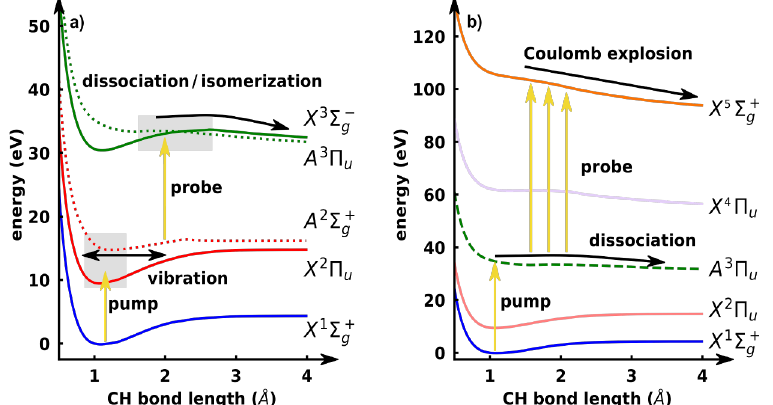
Fig. 1. Potential energy curves for various states in neutral and various charged states of acetylene as a function of CH-bond length. In scenario a) the pump pulse ionizes the molecule into a bound cation state (here the X 2 Π u state) and a subsequent probe pulse populates a dissociative dication state (here the A 3 Π u state). In scenario b), the pump pulse directly populates the dissociative dication state (A 3 P u ), and the probe pulse induces fragmentation from a quadruple charged molecular